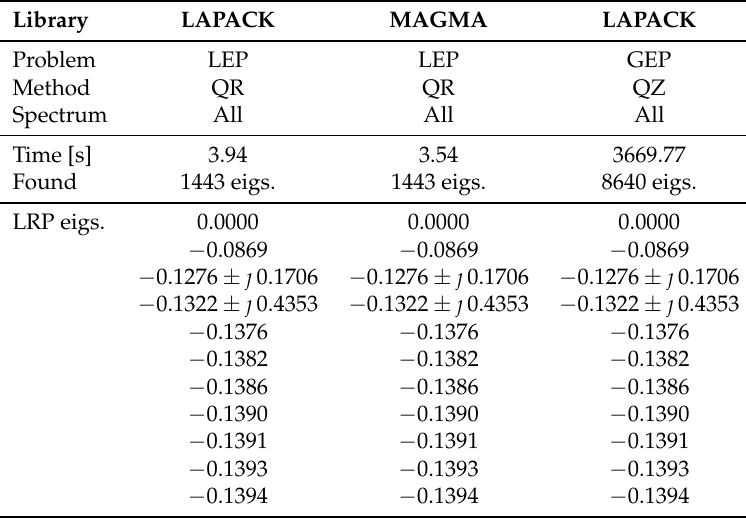
Table 7. AIITS: Schur decomposition methods, LEP and GEP.